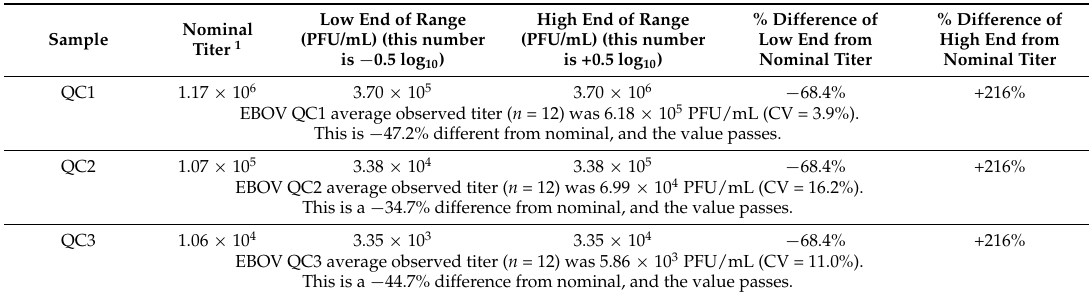
Table 1. Ebola Virus (EBOV) accuracy results in the context of the ranges of acceptable low and high % differences for both sets of Quality Control 1 (QC1), QC2 and QC3.